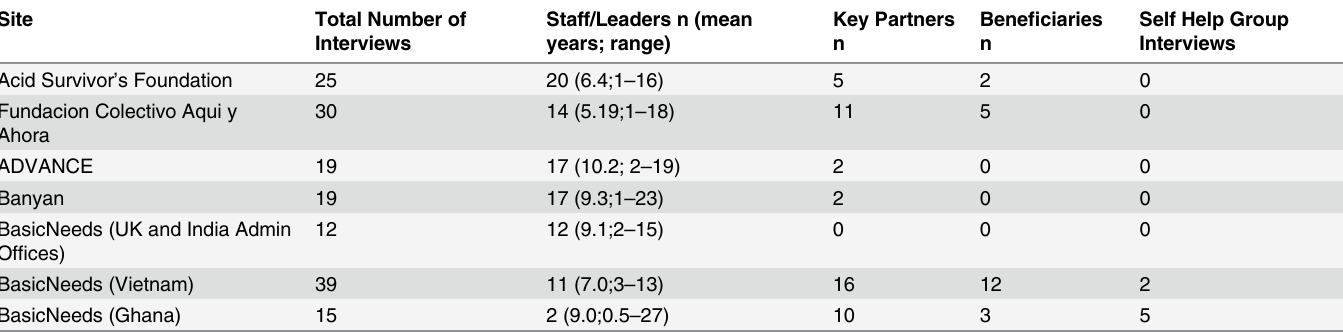
Table 2. Interview Details by Case Study